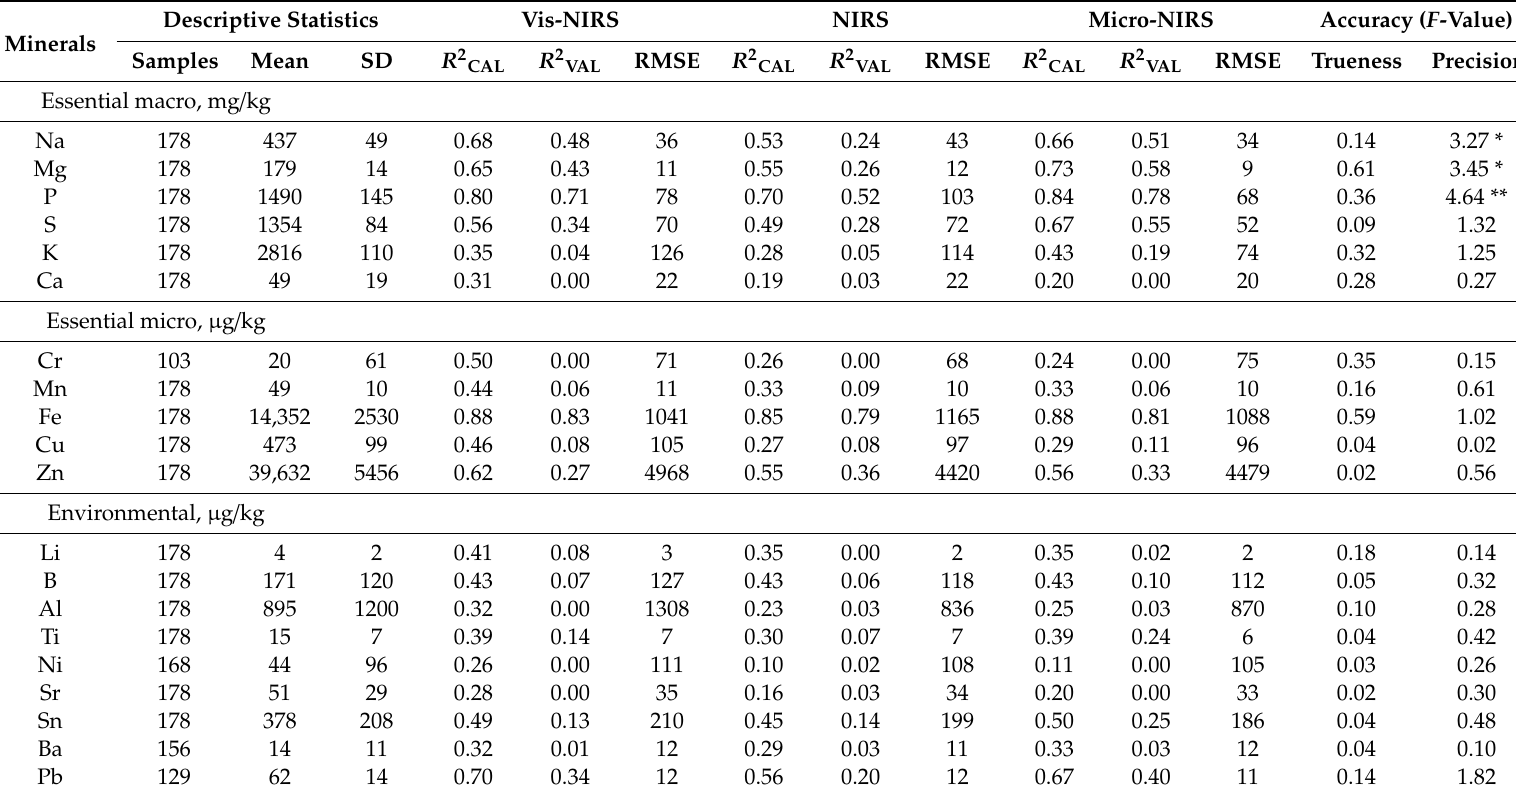
Table 3. Descriptive statistics and performances of the calibration and validation models for predicting mineral contents from meat absorbance spectra using three portable